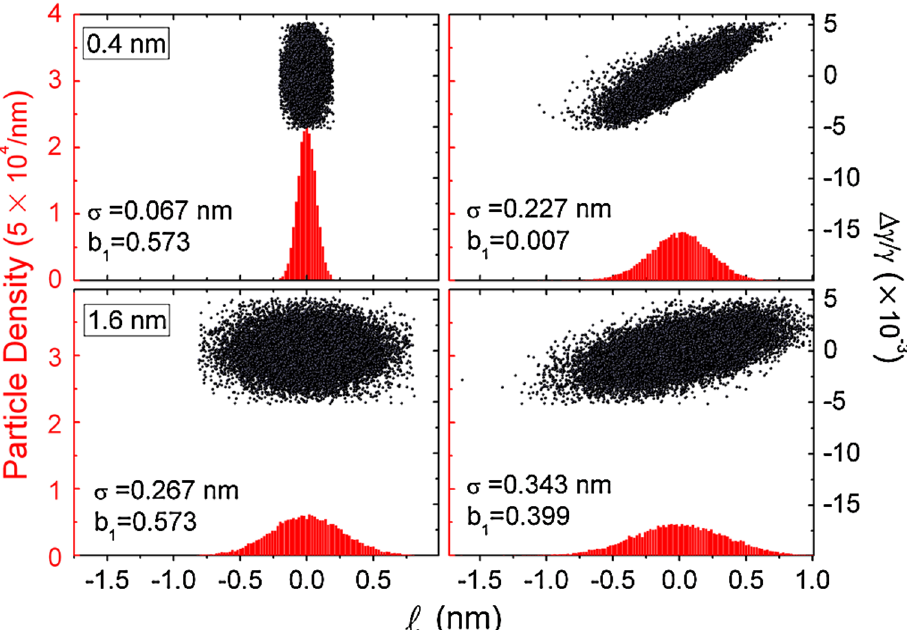
¼ 1 : 6 nm . 6 (cid:5) of the indicated microbunch r